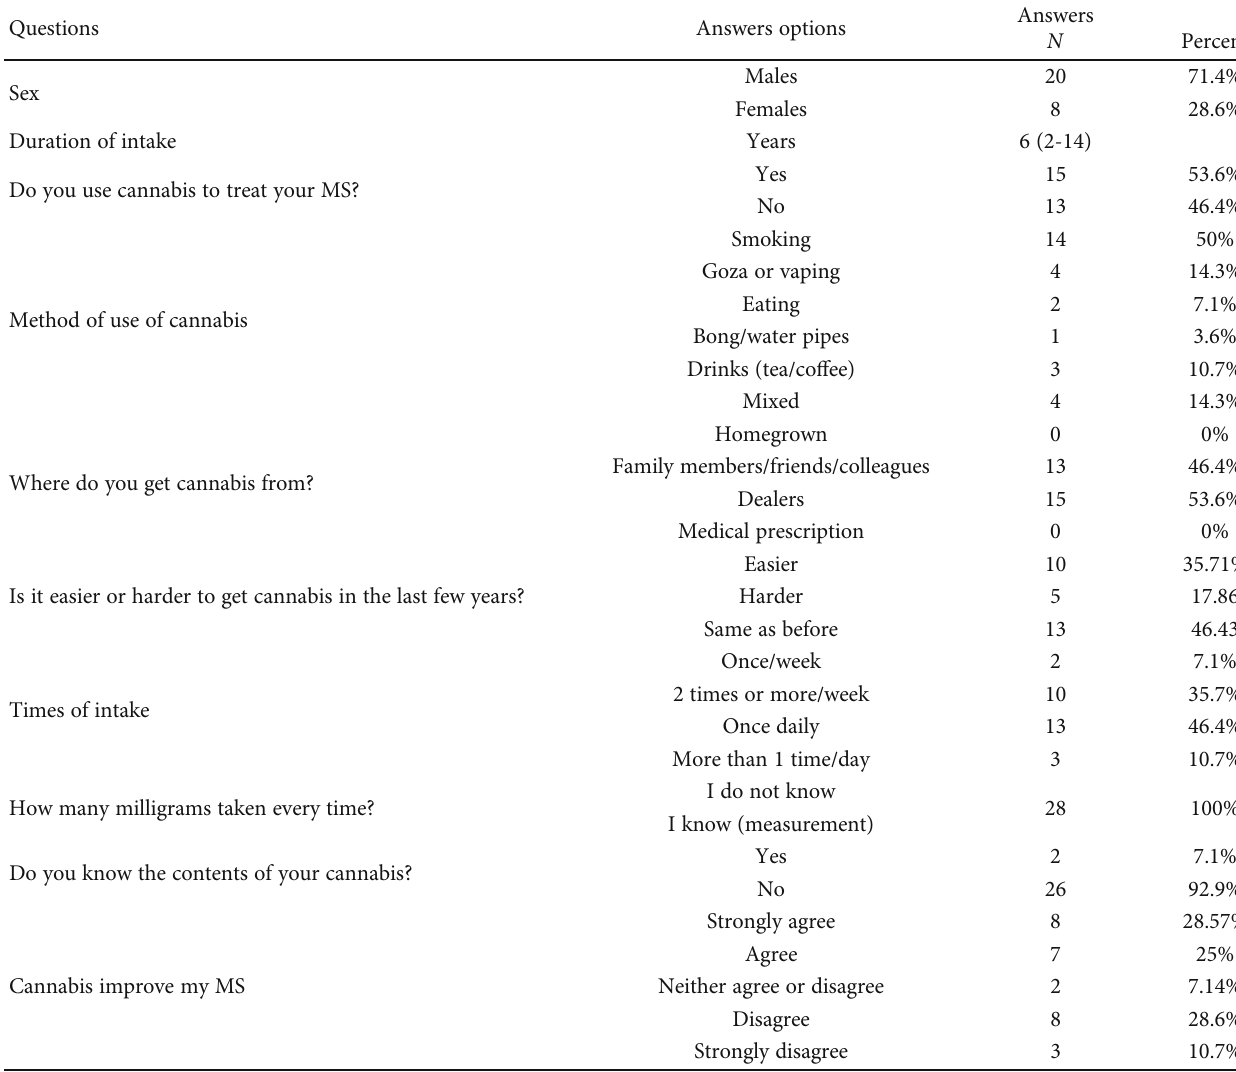
Table 2: Summary of cannabis use survey responses ( N = 28